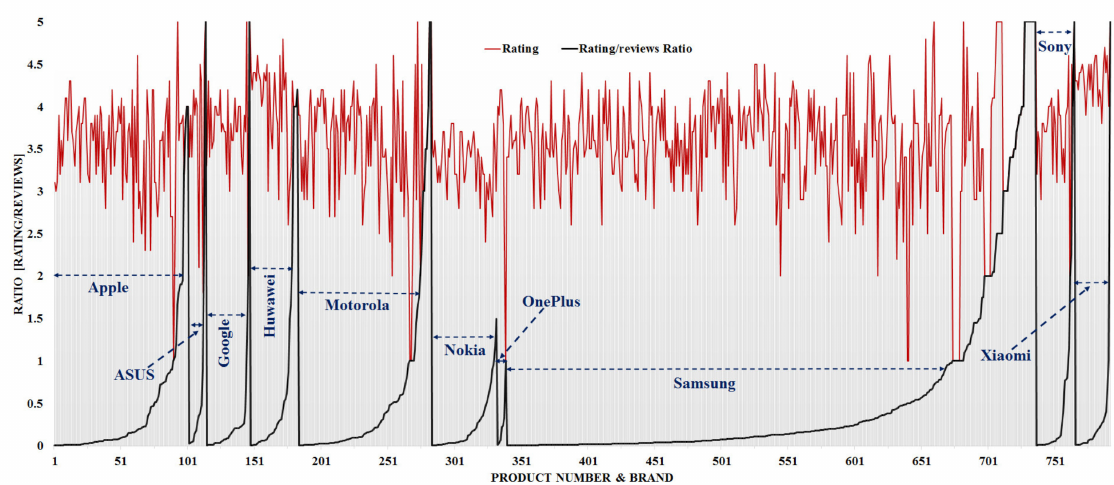
Figure 10. Brand wise evaluated MRR value as per product rating for all cellphones in the